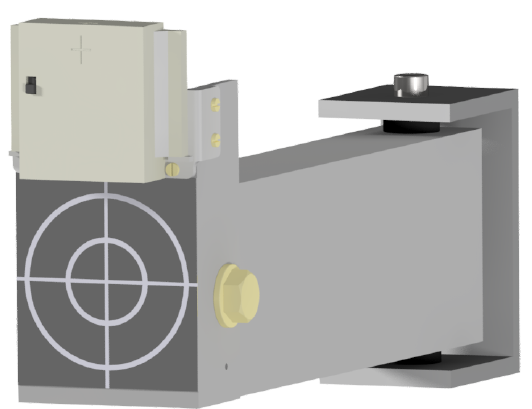
Figure 2. UWB module in a plastic housing as it is mounted on the wall with the mount. Under the module is a target for the geodetic reference measurements of the anchors’ positions. The relationship between the antenna center and a geodetic target is known.